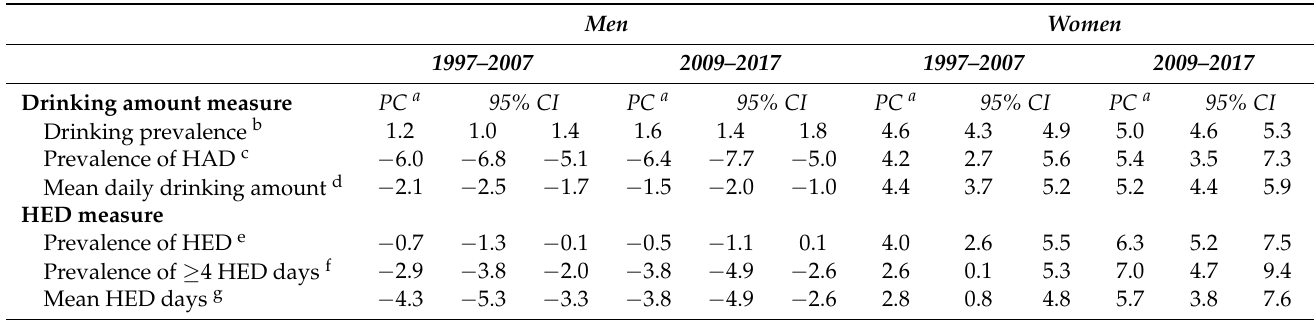
Table 4. Educational gradients in drinking amount and frequency of heavy episodic drinking in the last 30 days among population aged 25–64 by sex and calendar period, Spain 1997–2017.